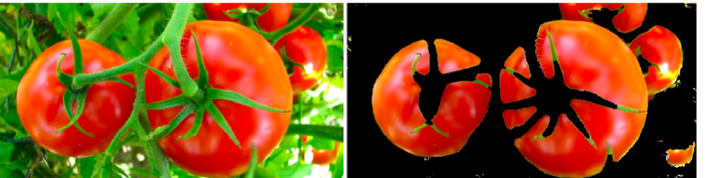
Figure 14. Original image ( left ) and final processed image ( right ).